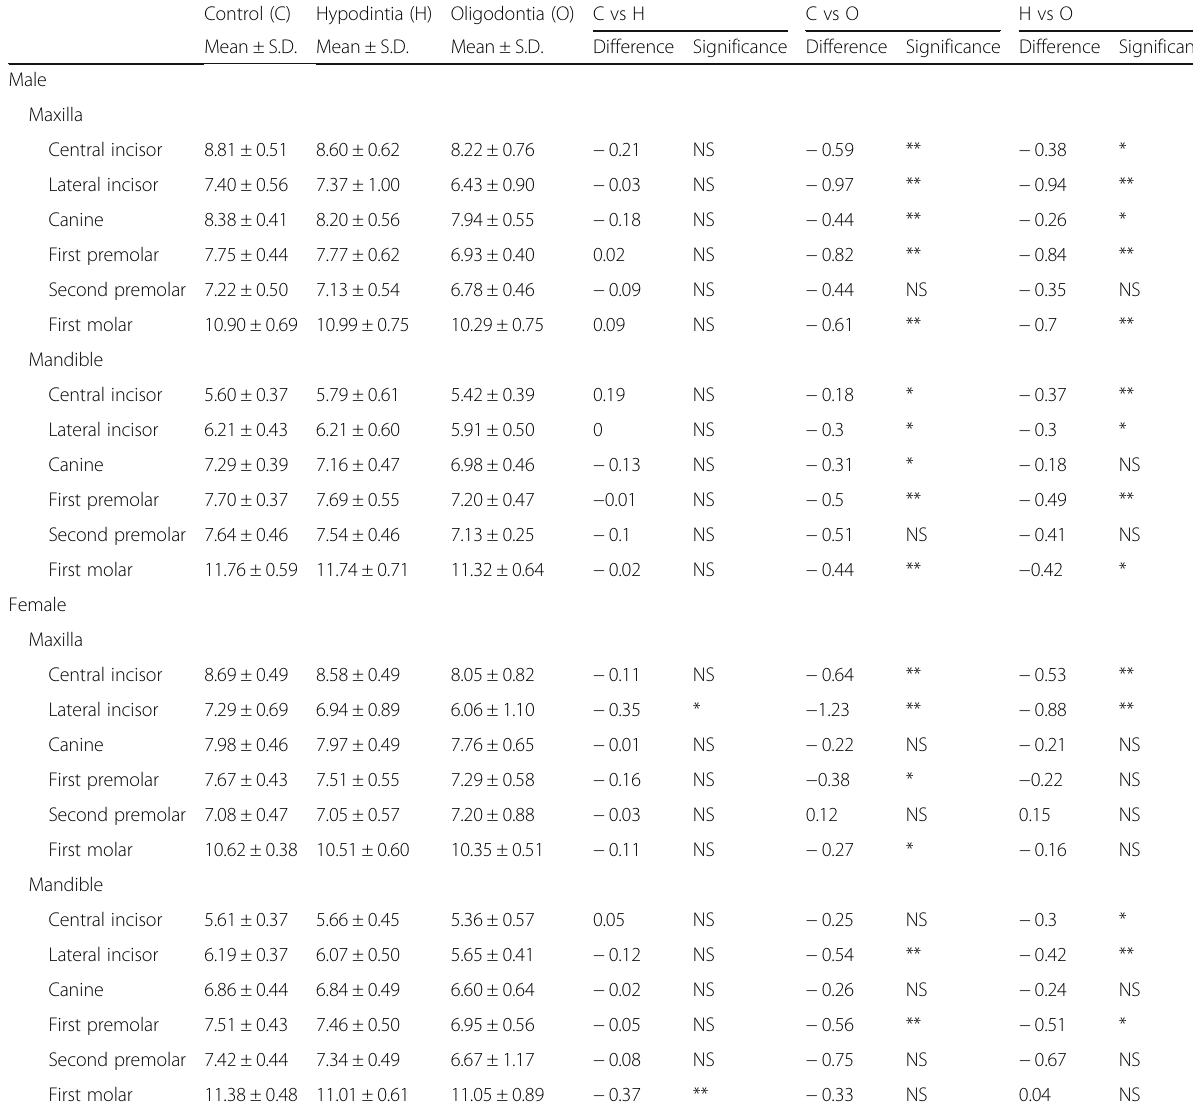
Table 1 Tooth size reduction in tooth agenesis Japanese patients Control